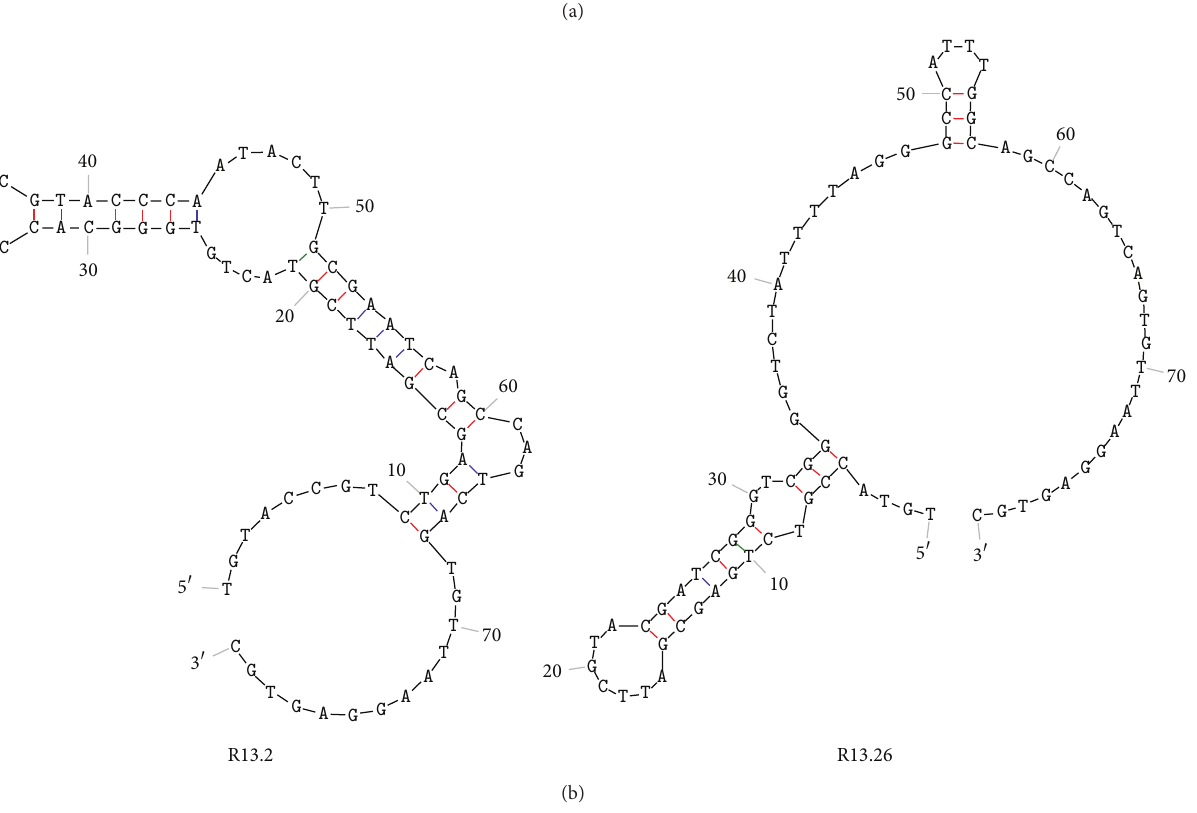
Figure 3: Sequence and structure of selected bromacil MREs. (a) ssDNA sequence of bromacil MREs R13.2 and R13.26 selected after 13 rounds of SELEX. (b) R13.2 and R13.26 secondary structure as predicted by Mfold [26, 27].